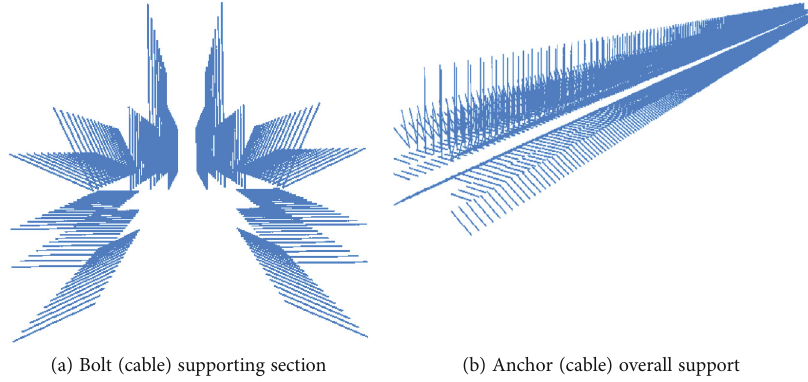
Figure 9: Anchor (cable) support model.